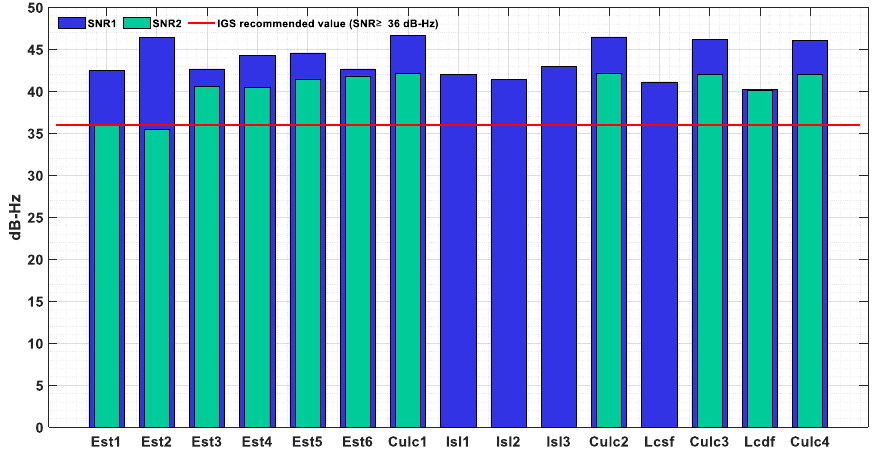
Figure 7. Signal-to-noise ratio (SNR). Red line: 36 dB-Hz according to [41].